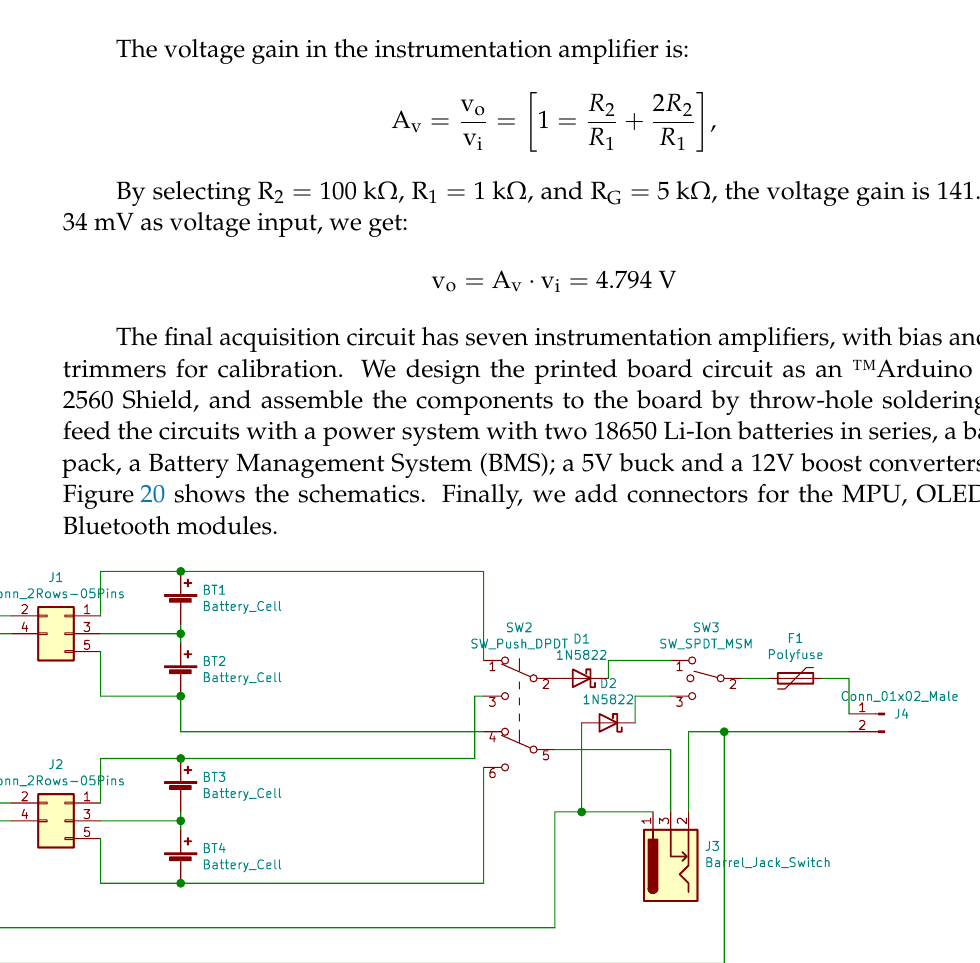
Figure 20. Power system with backup, BMS, boost, and buck